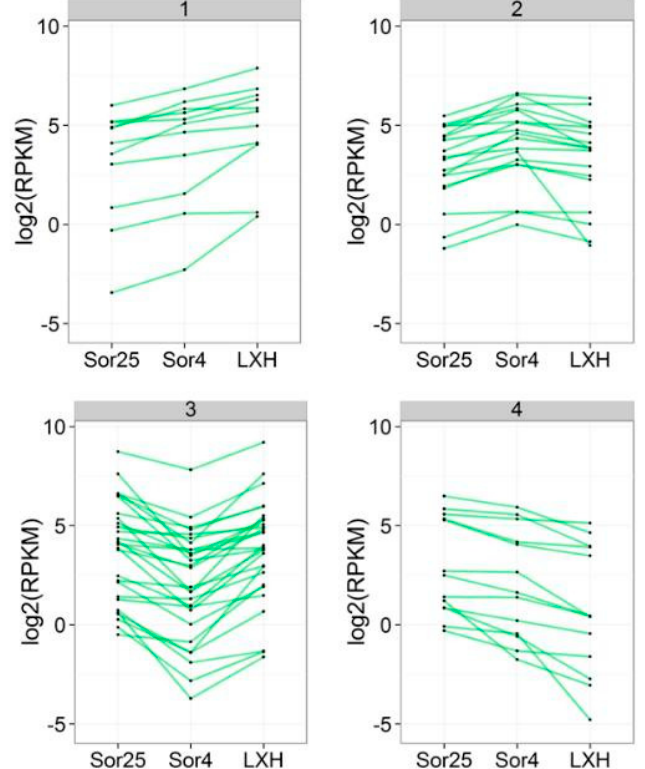
Figure 2. Expression patterns of carbohydrate metabolism genes. Sor25 means that the Oriental lily ‘Sorbonne’ growth point is not vernalized yet, Sor4 means oriental lily ‘Sorbonne’ growth point vernalization completion period, and LXH means the Oriental lily ‘Sorbonne’ growth point flower bud differentiation period.